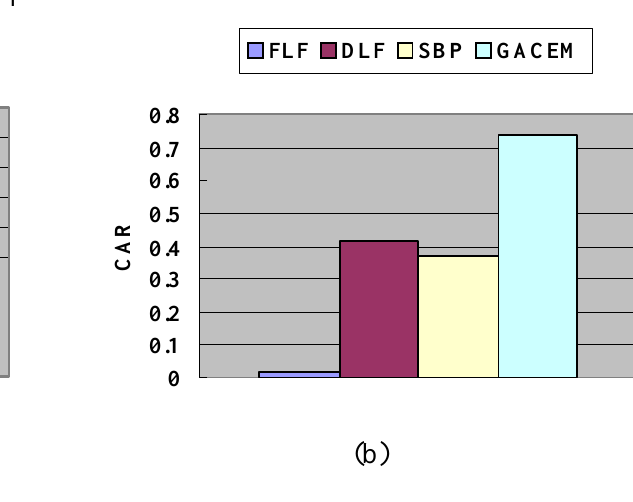
Figure 9. Classification accuracy rate of GACEM with different basic classifier: (a) LDC, (b) QDC, (c) k-NN and (d)